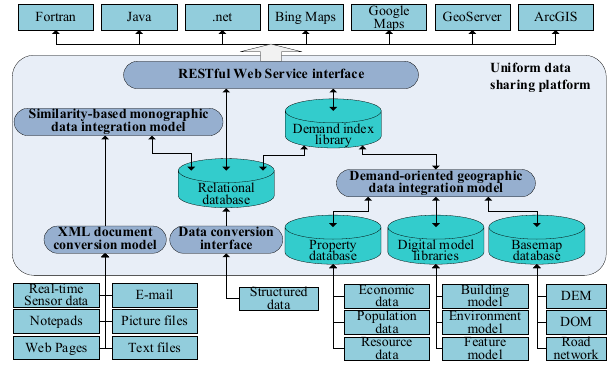
Fig. 4. Architecture of the uniform data sharing